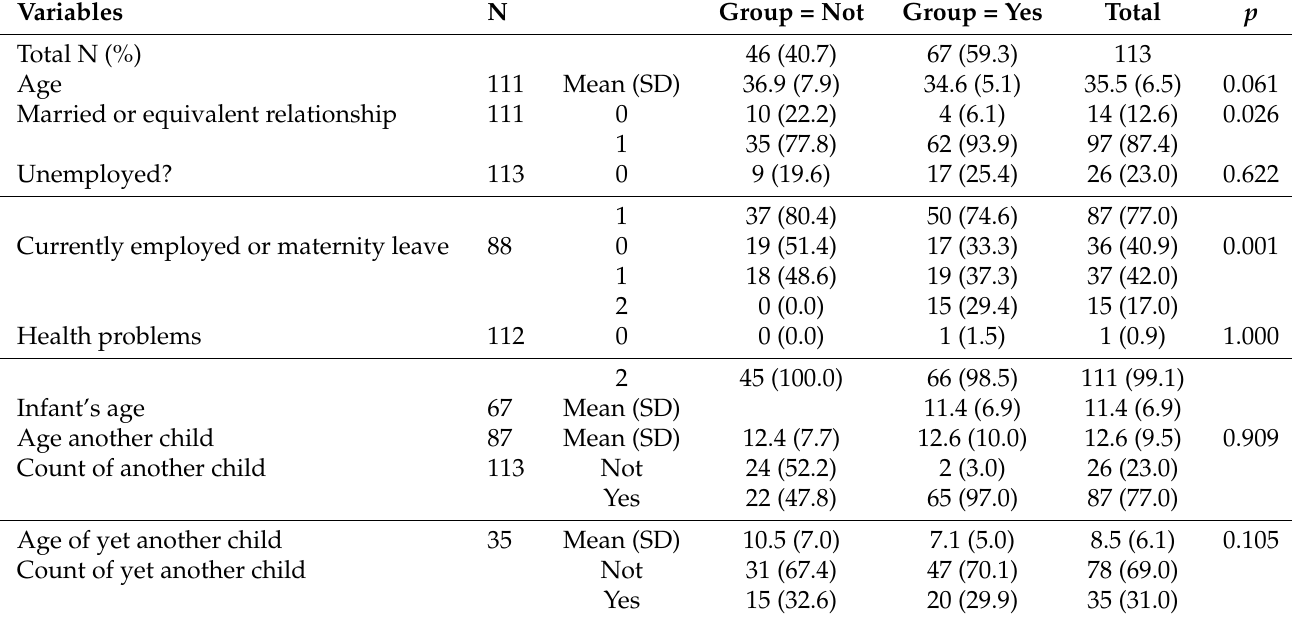
Table 1. Descriptive statistics for the two samples of women that participated in the study. Group = Yes were mothers who were taking care of infants under 24 months old at the time of the study and Group = Not were women without children under 6